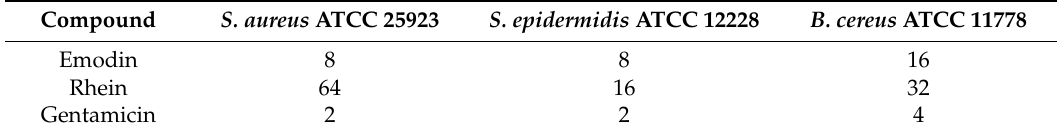
Table 3. MIC values of the tested compounds ( µ g/mL).